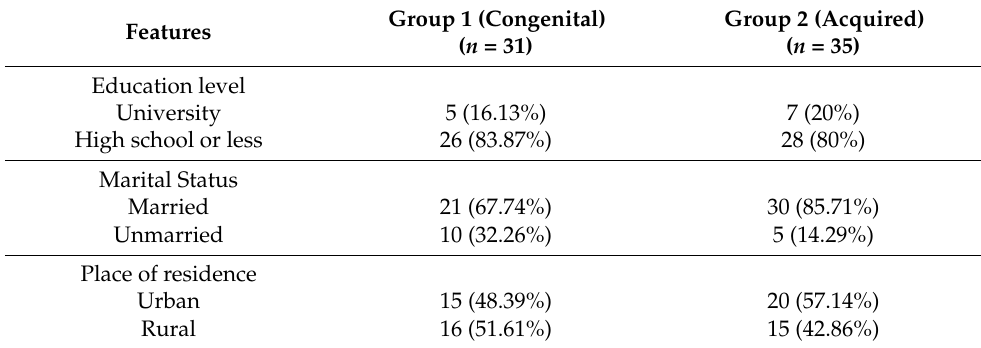
Table 1. Features of the 2 groups (total = 66 participants).